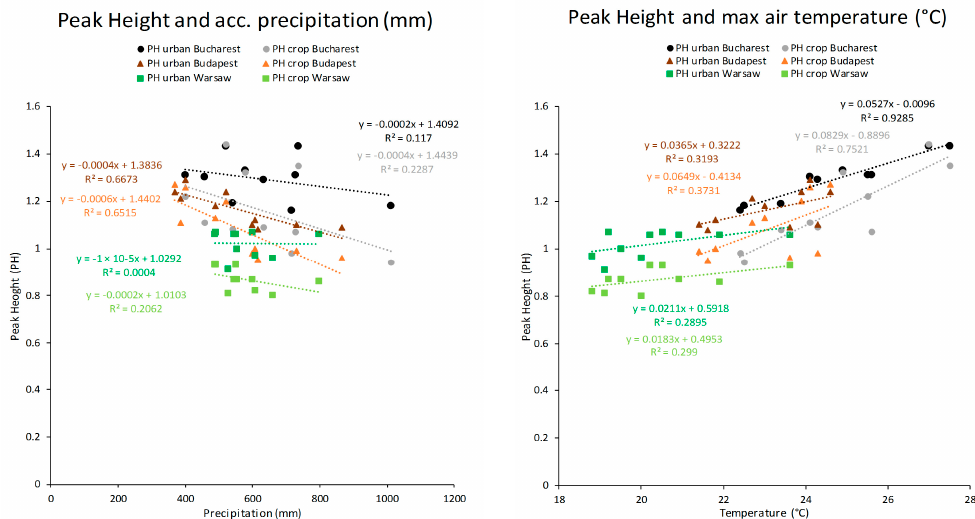
Figure 13. Relationships between peak height and accumulated precipitation ( left ) and maximum air temperature ( right ).